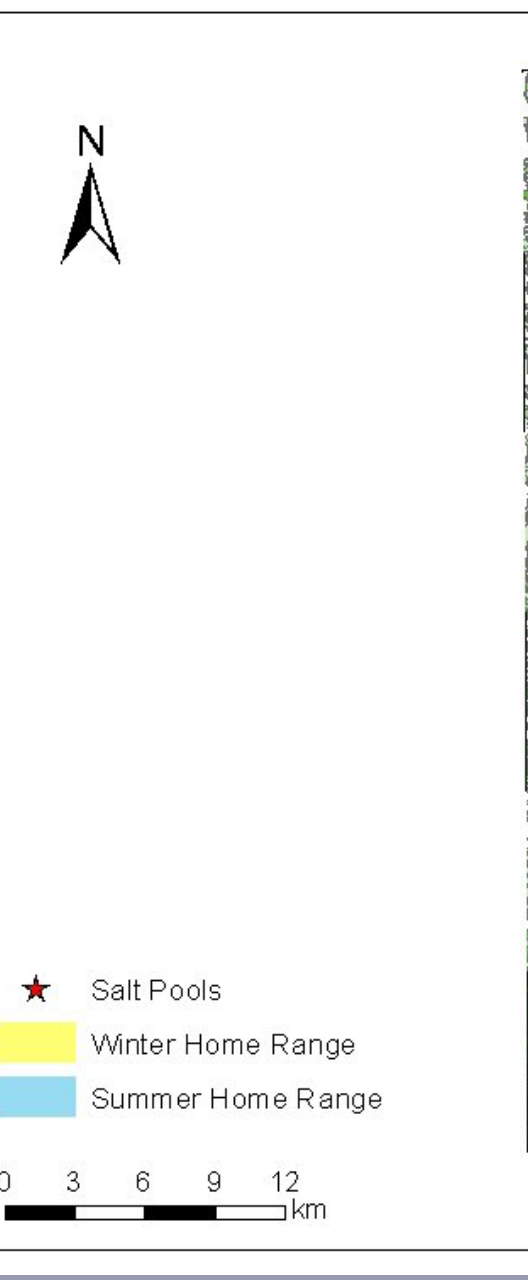
Fig. 2 . The winter (1 October–30 April) and summer (1 May–30 September) home ranges of three moose. Note that each summer range is elongated to encompass the roadside salt pools. The home range boundaries were drawn based on GPS telemetry data, approximating the minimum concave polygon